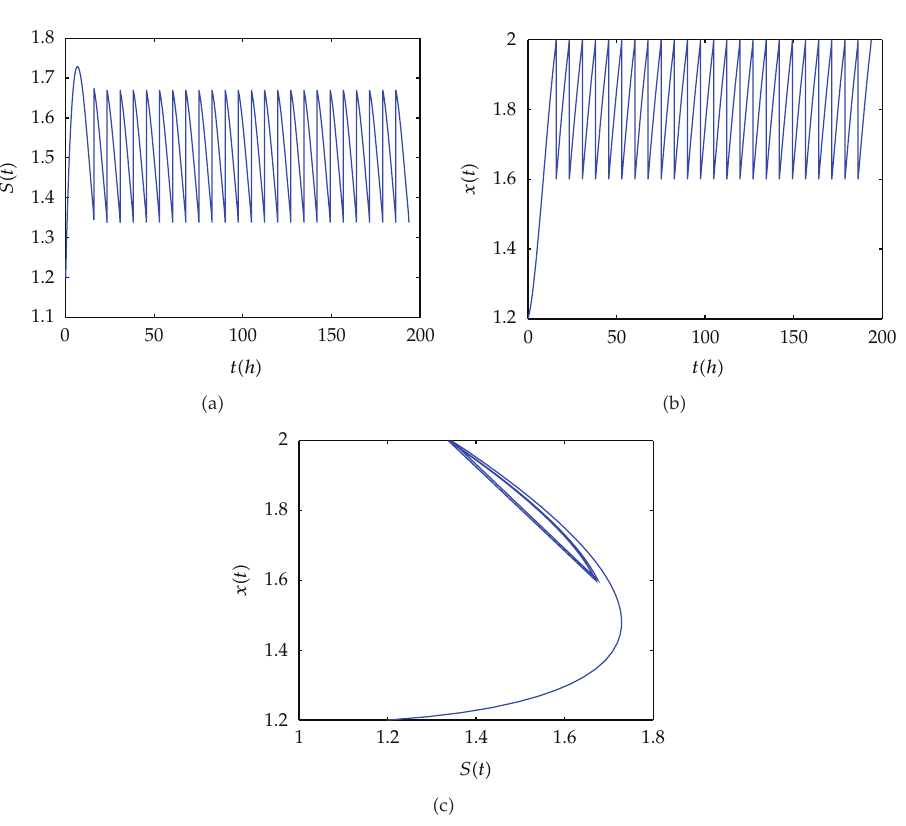
Figure 8: The time series and phase diagram for system (cid:5) 2.6 (cid:6) starting from initial point (cid:5) S 0 ,x 0 (cid:6) (cid:7) (cid:5) 1 . 2 , 1 . 2 (cid:6) with a (cid:7) 2, b (cid:7) 1 . 5, x set (cid:7) 2 (cid:3) g/l (cid:4) , and W f